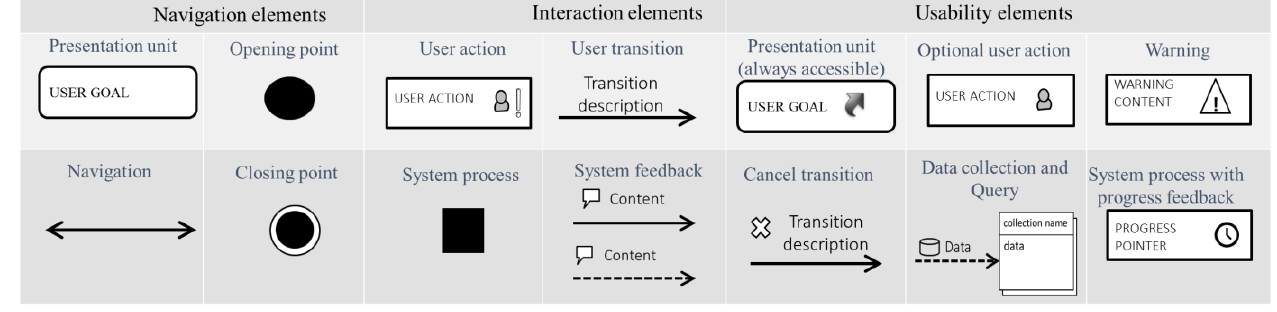
Fig 7. USINN elements to represent interaction, navigation and usability - new version after feasibility study.